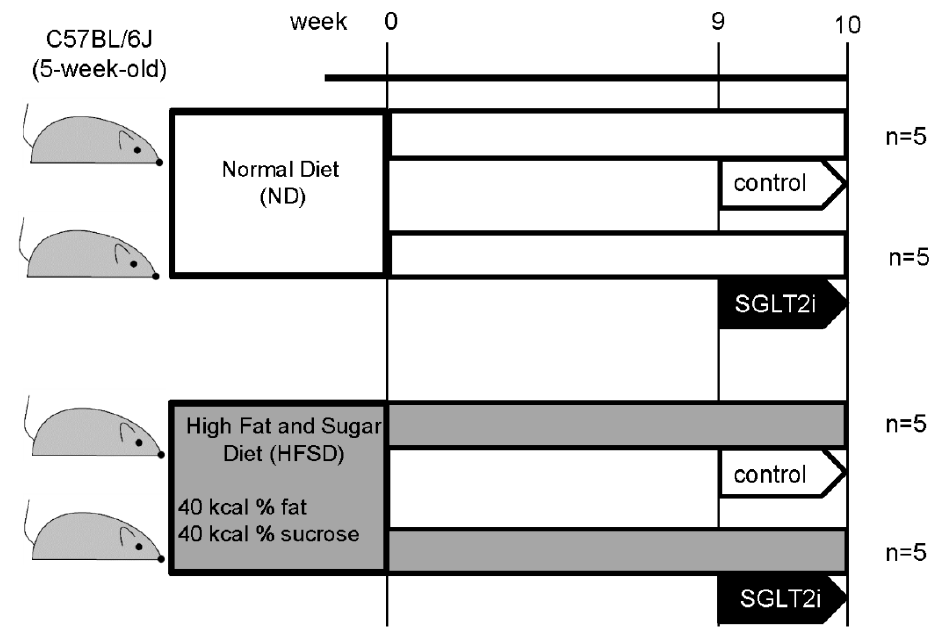
Figure 1. Physiological and metabolic parameters in normal diet (ND)-fed group and high-fat and -sugar diet (HFSD)-fed group. Results are presented as the mean ± standard deviation. Differences were evaluated by two-way ANOVA followed by Tukey–Kramer test; * p < 0.05 vs. control ND, # p < 0.05 vs. control HFSD. SGLT2i: empagliflozin.